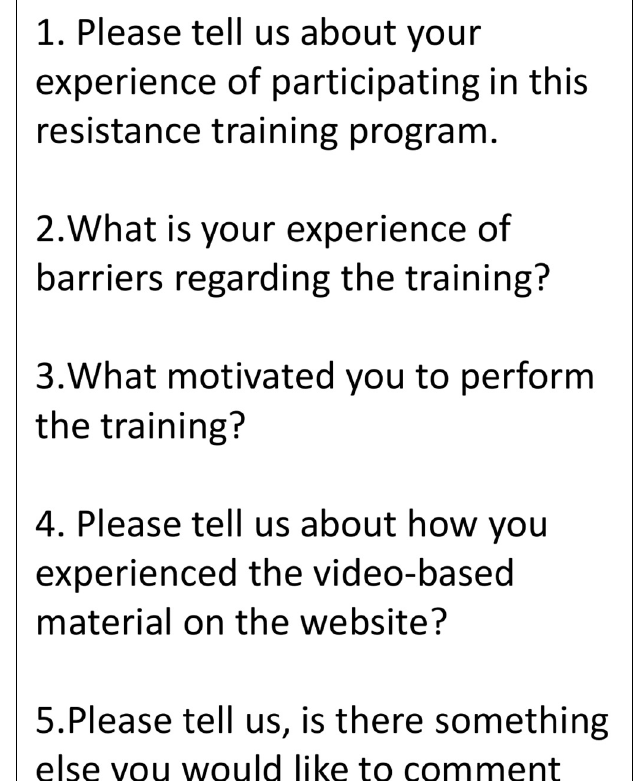
FIGURE 1 | Interview guide illustrating the questions of the